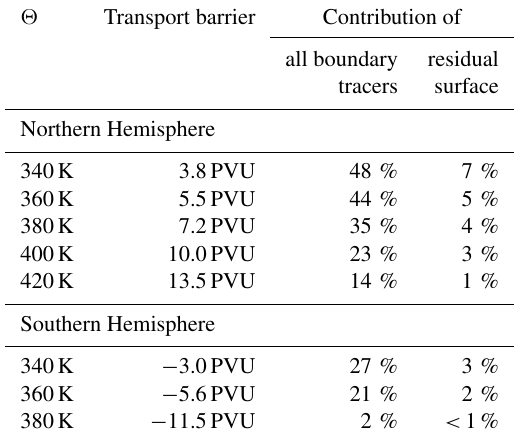
Table 2. The contributions of all boundary emission tracers to the composition of the extratropical lower stratosphere at the end of October 2012 at different levels of potential temperature using the climatological isentropic transport barrier derived by Kunz et al. (2015) for the Northern and Southern hemispheres. The highest contributions are from India/China, southeast Asia, and the tropical Pacific Ocean. The contributions of all other regions of the Earth’s surface are of minor importance (residual surface).